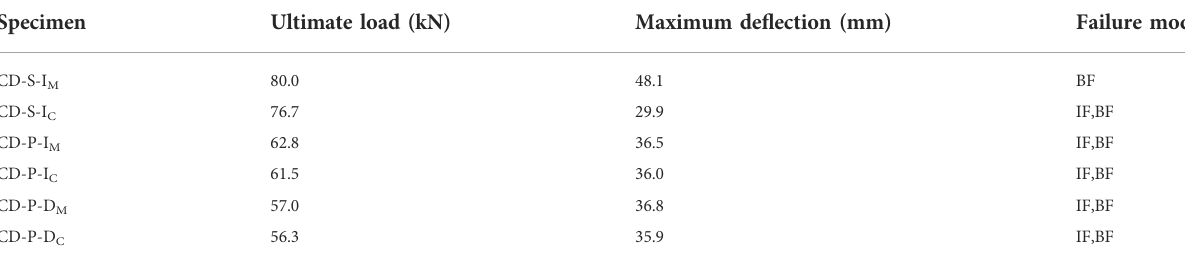
TABLE 6 Bending properties of steel-UHPC composite bridge